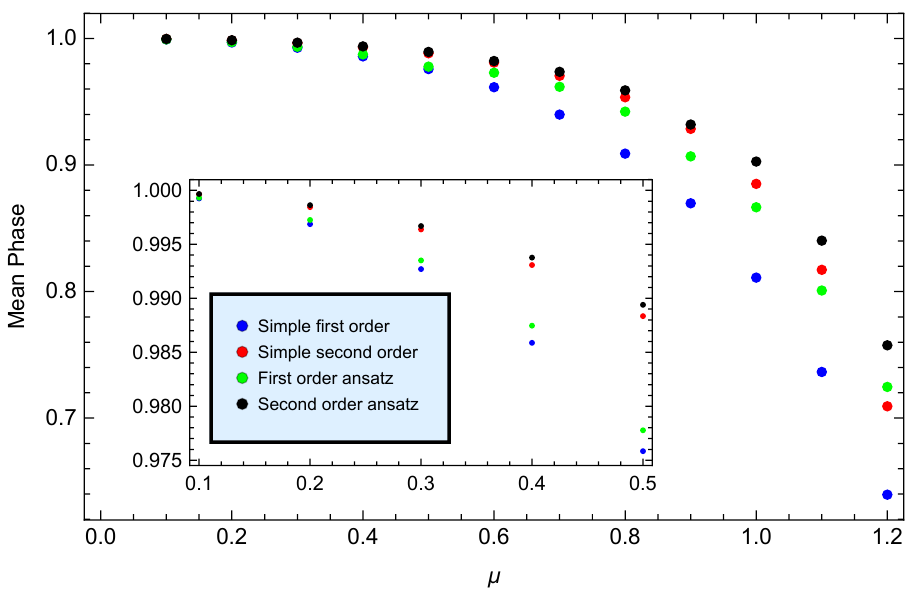
Figure 15 . The mean phase factor as a function of µ for various contours for m = 1 , L = 8 . The values at the range µ ≤ 0 . 5 are inset with a magnified y -axis scale for clarity.